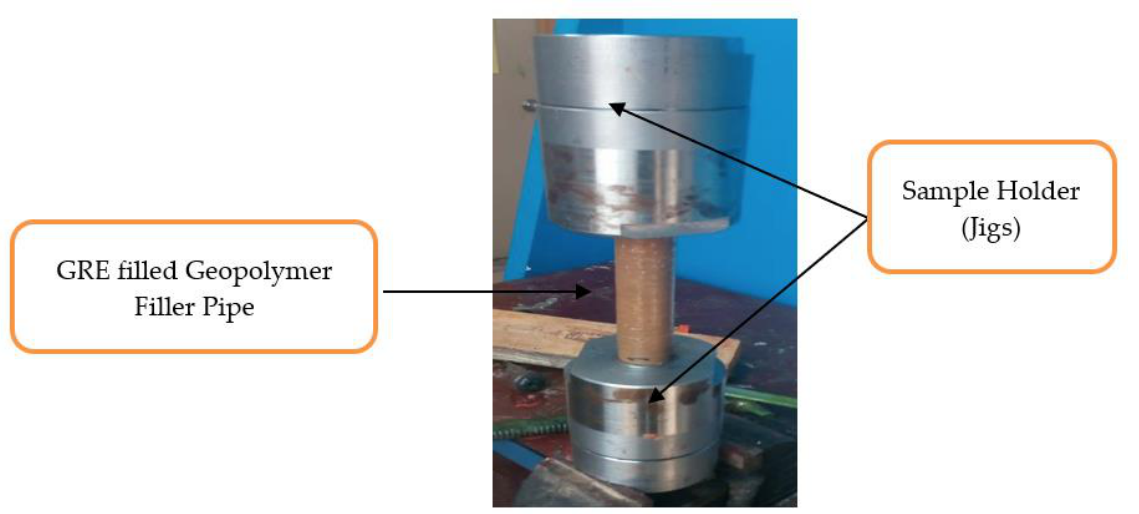
Figure 4. Schematic diagram of flame test.